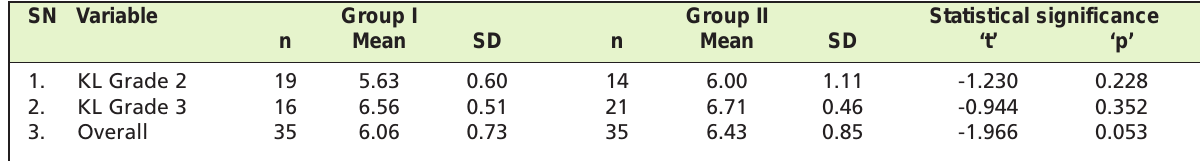
Comparison of two groups according to Pre-intervention VAS Table IV: